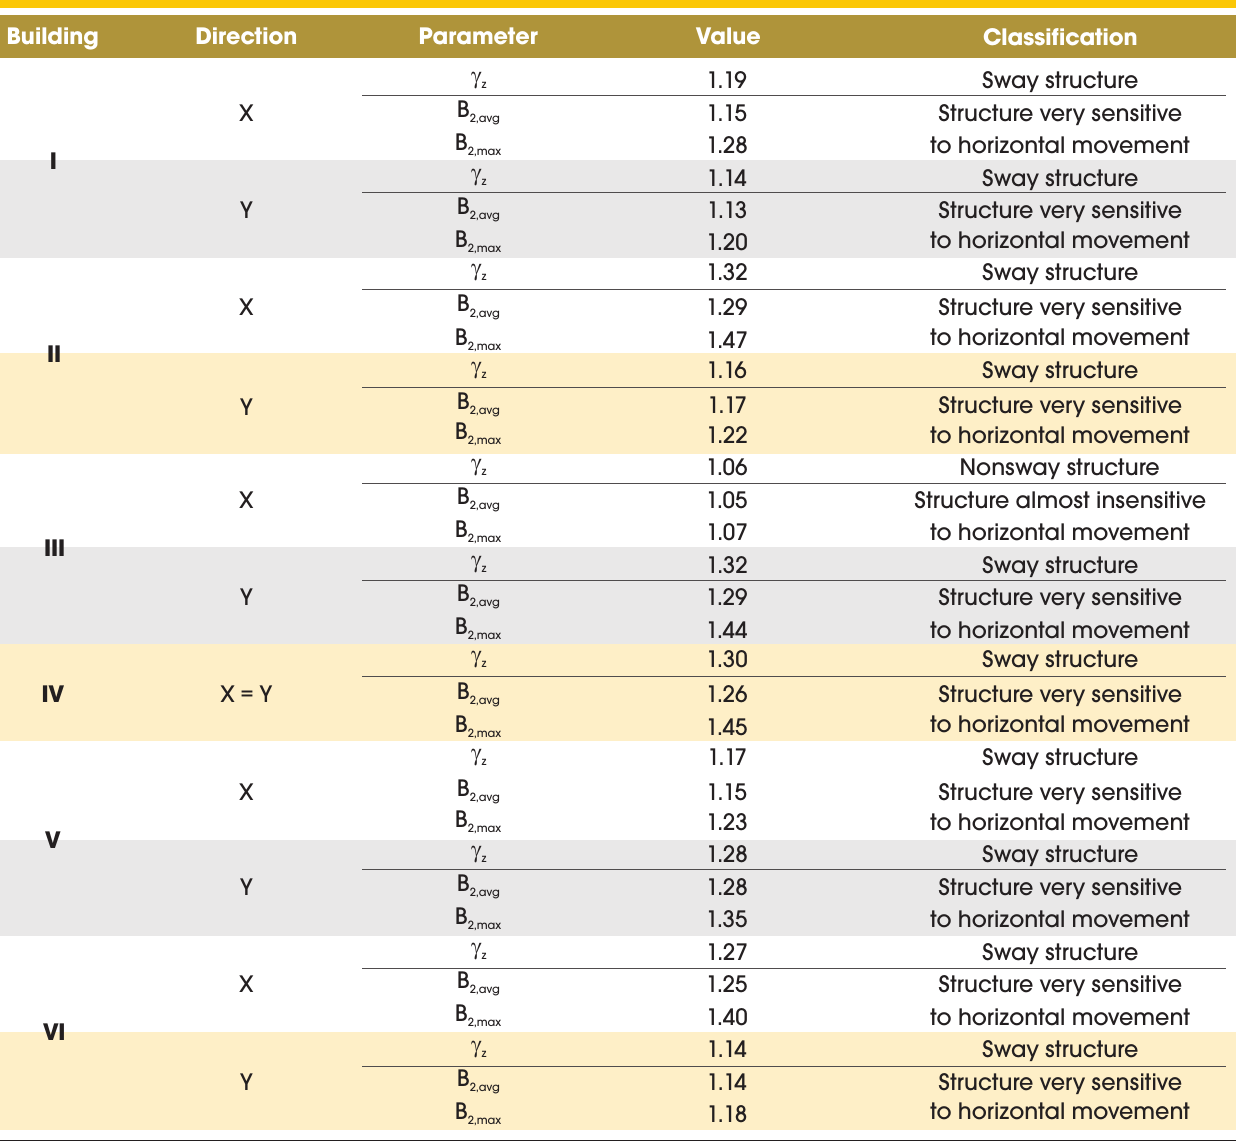
Table 6 – Values obtained for the  and B coefficients and structure classification z